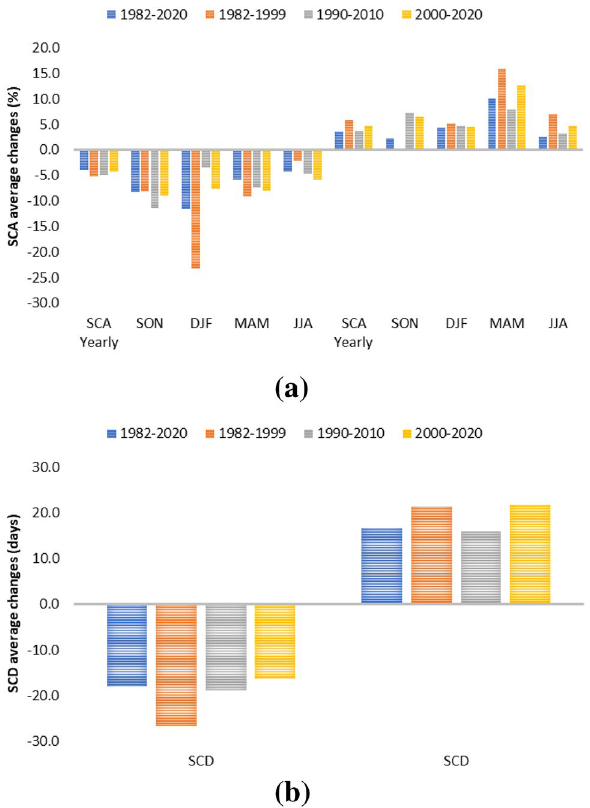
Figure 4. Average magnitude of positive and negative changes for ( a ) SCA at year level and in different seasons, ( b ) for SCD. The average is calculated over the areas with a significant trend at 5%